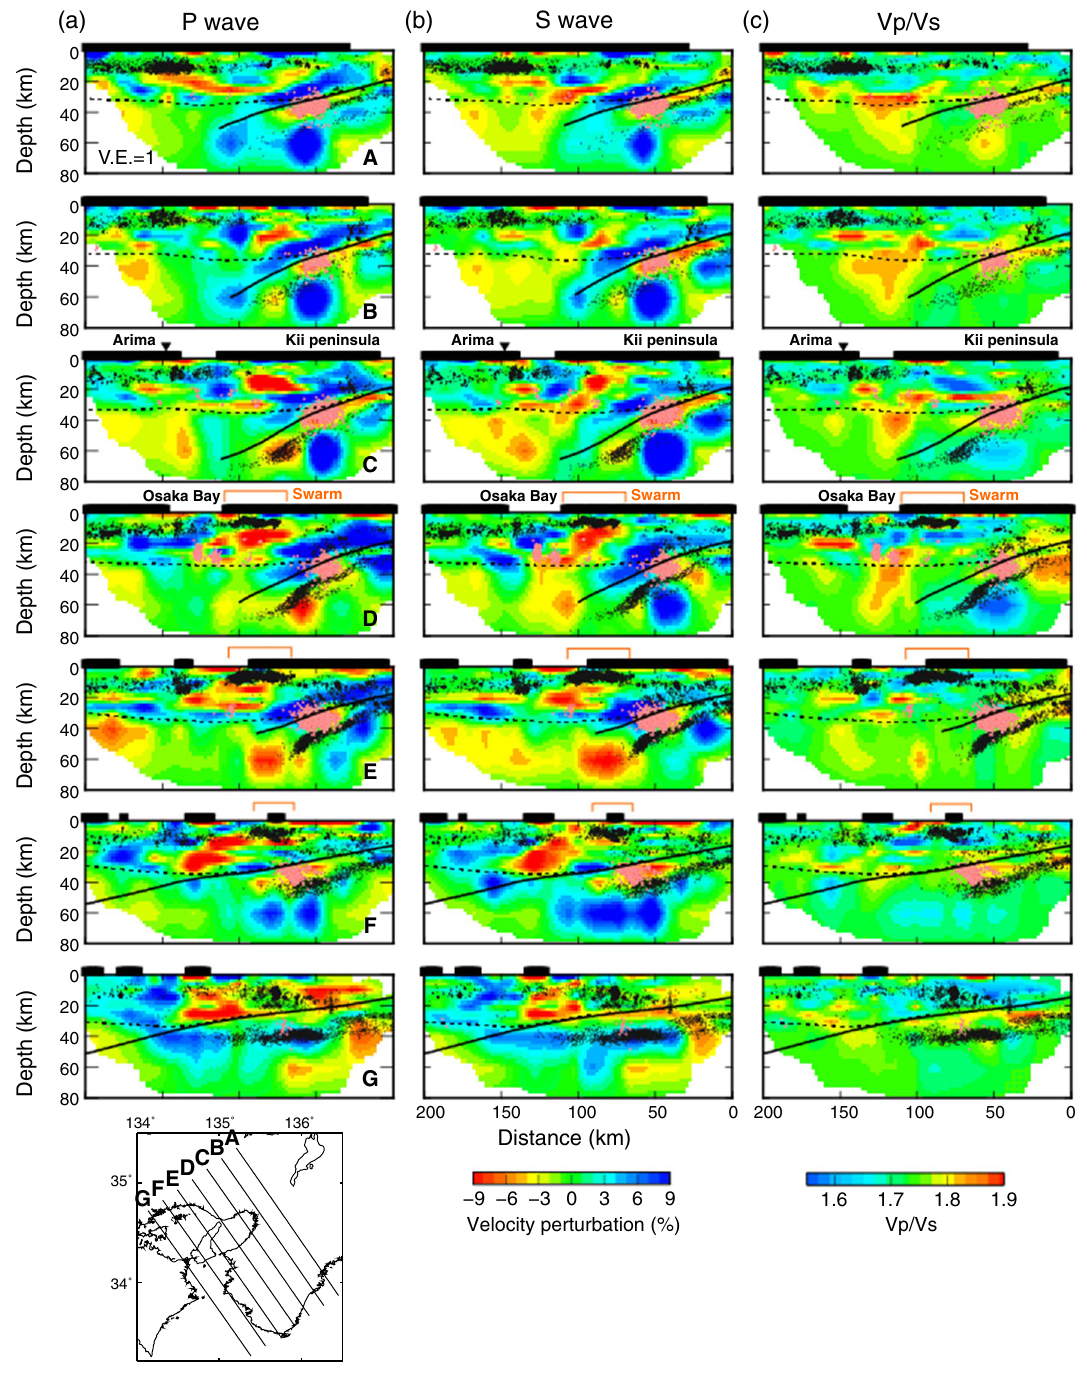
Fig. 10 Vertical cross sections of the a P-wave and b S-wave velocity perturbations and c V p / V s ratios along the seven profiles (A–G) shown on the inset map. Black dots and red circles denote the earthquakes and LFEs, respectively, within a 5-km-wide zone along each profile. Black dashed and black solid lines denote the Moho (Katsumata 2010) and upper surface of the PHS slab (Nakajima and Hasegawa 2007b; Hirose et al. 2008), respectively. Black bars on the surface represent the land